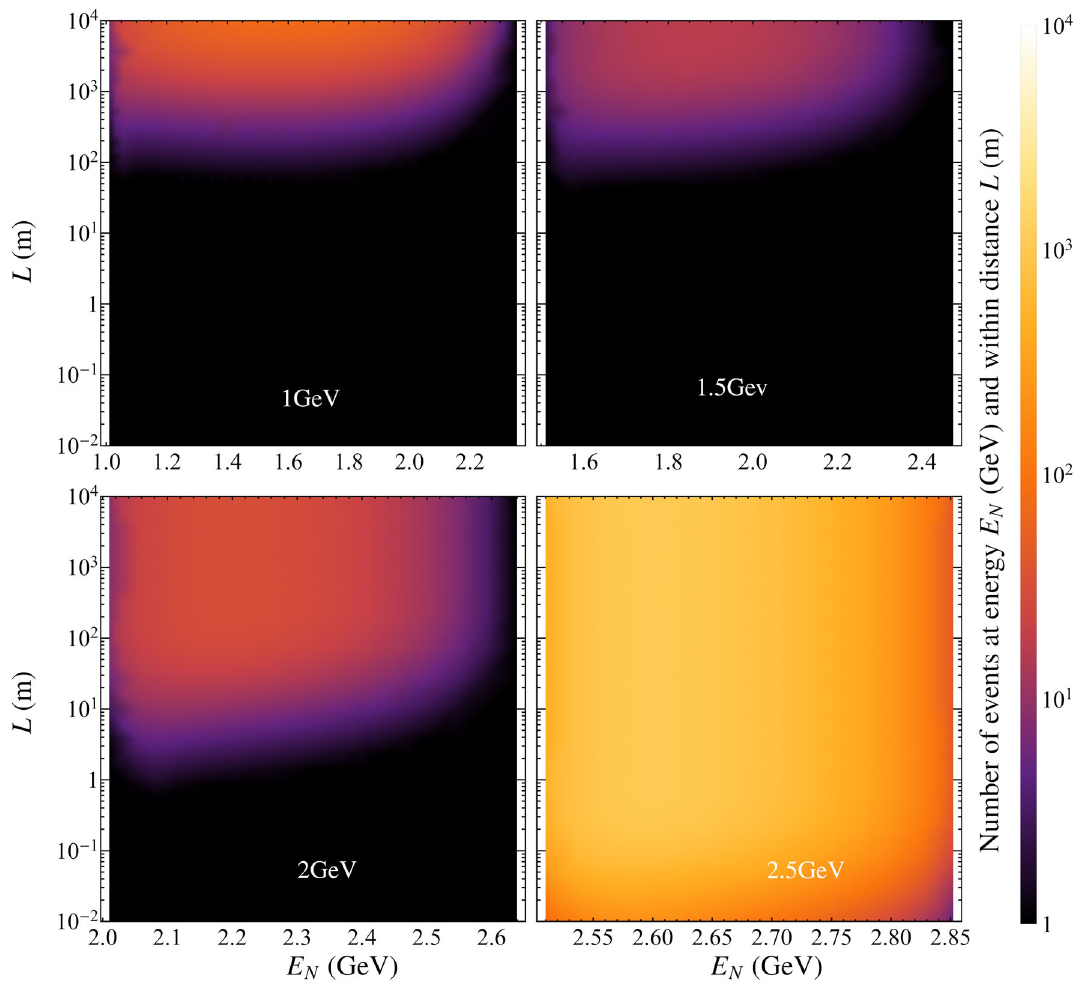
Fig. 5 Distribution of events for various energies of the neutrino as measured in the B rest frame and considering the events with various displaced vertices of lengths. Here the decays happen within the dis- tance L and only those decays with L (cid:2) 1 m are currently feasible